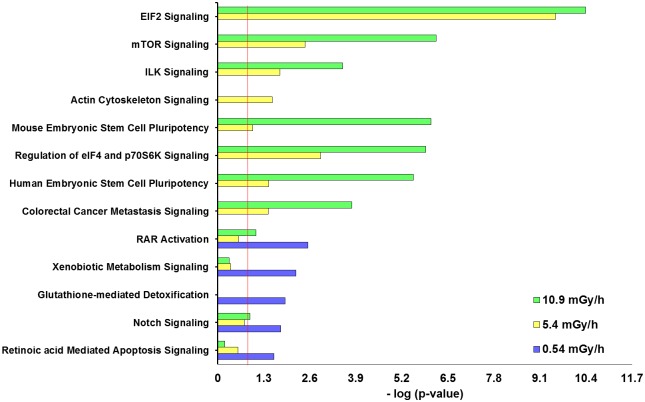
DEG functional analysis (IPA).Top signaling pathways in canonical pathway comparison between all exposure groups: 0.54 mGy/h, 5.4 mGy/h and 10.9 mGy/h. The rankings were based on Fisher's exact test and high-ranking categories are displayed along in a decreasing order of significance from top. The threshold line (red) denotes the cut-off for significance (p-value 0.05).